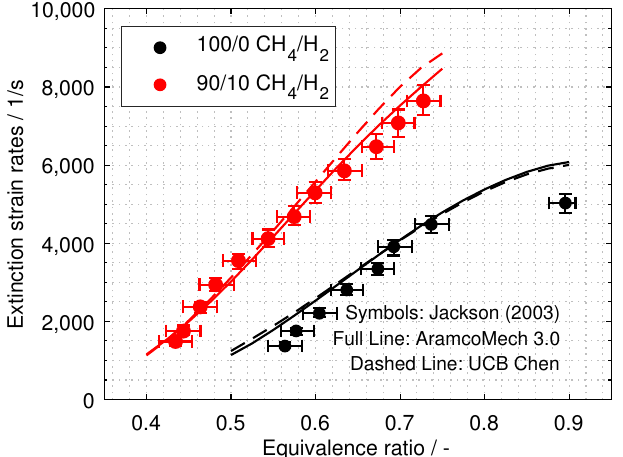
Figure 7. Experimental [65] and modeling results for the extinction strain rate of 0 and 10 mol − % H 2 in a premixed CH 4 flame ( T gas = 573K) as a function of the equivalence